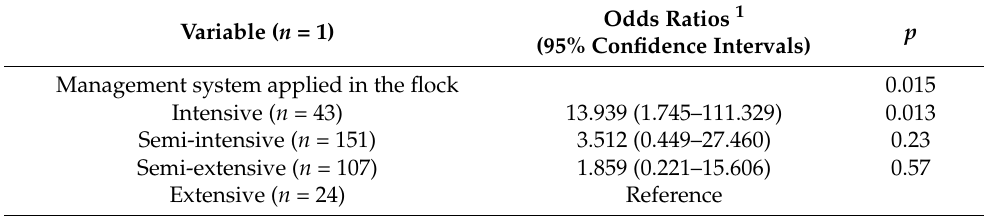
Figure 4. Proportion of flocks from which multi-resistant staphylococcal isolates were recovered, in accordance with the management system applied in these flocks (dashed line: trendline). Table 4. Results of multivariable analysis for isolation of multi-resistant staphylococcal isolates from the bulk-tank milk of 325 sheep flocks in Greece.